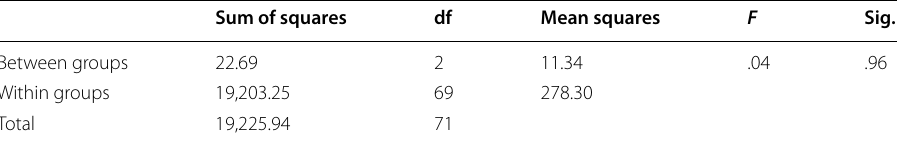
Table 7 Inferential statistics of the three groups on the self-regulation pre-tests Sum of squares df Mean squares F Sig.